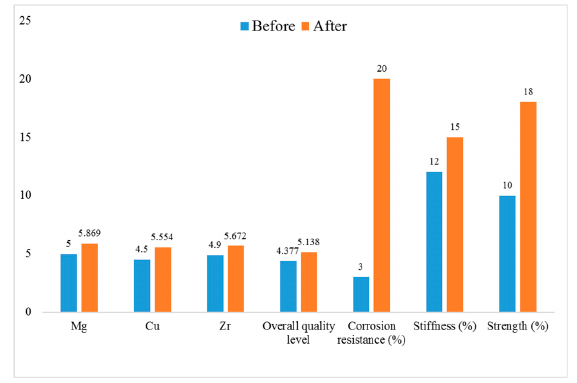
Figure 5. Comparison of the performance before and after the improvement.